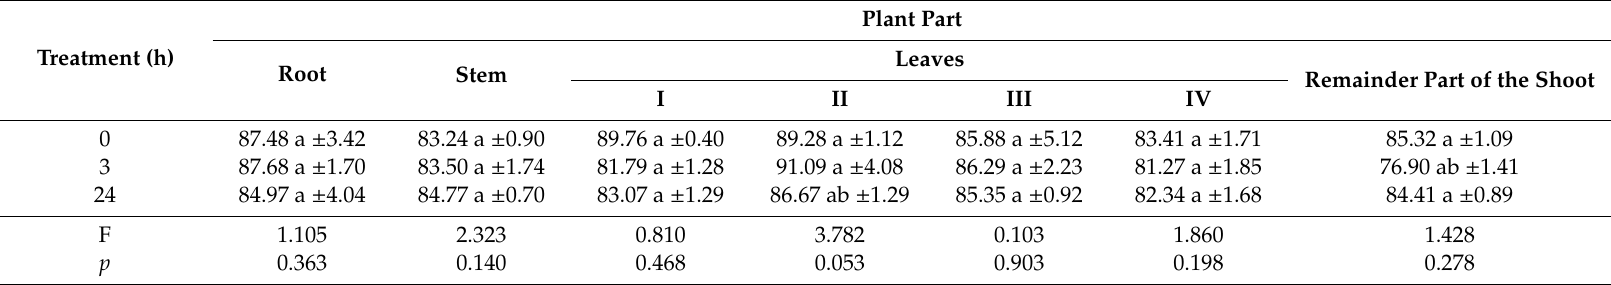
Table 8. Tissue water content (%) of triticale ( × Triticosecale Wittm. ex A.Camus) plants grown from grains irradiated with a helium-neon (He-Ne) laser by 3 and 24 h; mean ± SD (n = 10) values marked with di ff erent letters di ff er statistically according to Tukey’s test at p ≤ 0.05. Plant Part Treatment (h) Root Stem